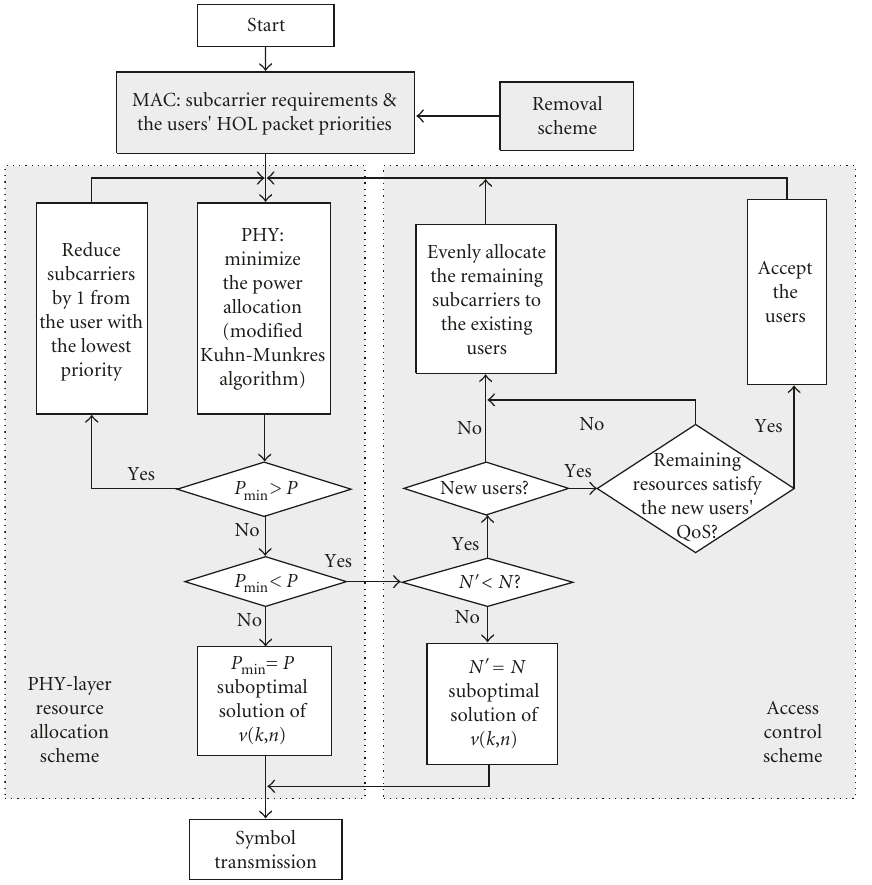
Figure 6: Flow chart of